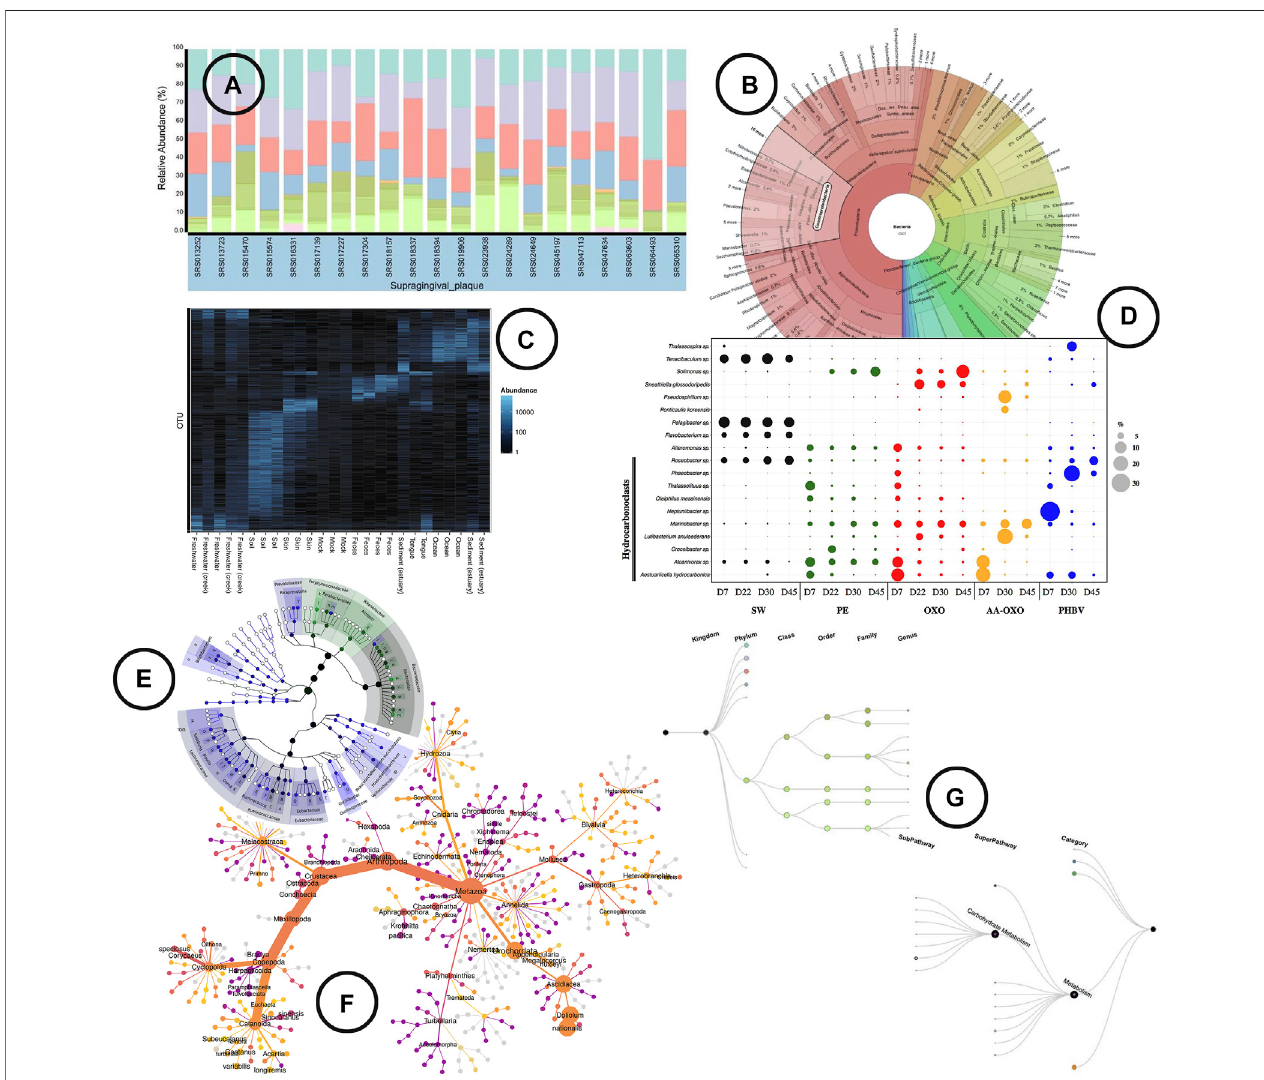
FIGURE 3 | An overview of the visual encodings used to display (relative) abundance and hierarchical/relational structures; (A) relative abundance displayed by means of a stacked bar chart in BURRITO (McNally et al., 2018), (B) a krona sunburst chart showing the taxonomic hierarchy of the observed bacteria and their relative abundance (Ondov et al., 2011), (C) OTU abundance visualized as a heatmap using Phyloseq (McMurdie and Holmes, 2013), (D) relative abundance of OTUs representedinabubbleplot(Dussudetal.,2018), (E) GraPhlAn,atreebasedvisualizationtoolthatallowstoaddvisualannotations(Asnicaretal.,2015), (F) a “ heat tree ” visualization showing the taxonomic hierarchy within its tree structure and OTU abundance using node width (Foster et al., 2017), (G) taxa and function hierarchy displayed within tree structures in BURRITO with node width representing abundance (McNally et al., 2018).